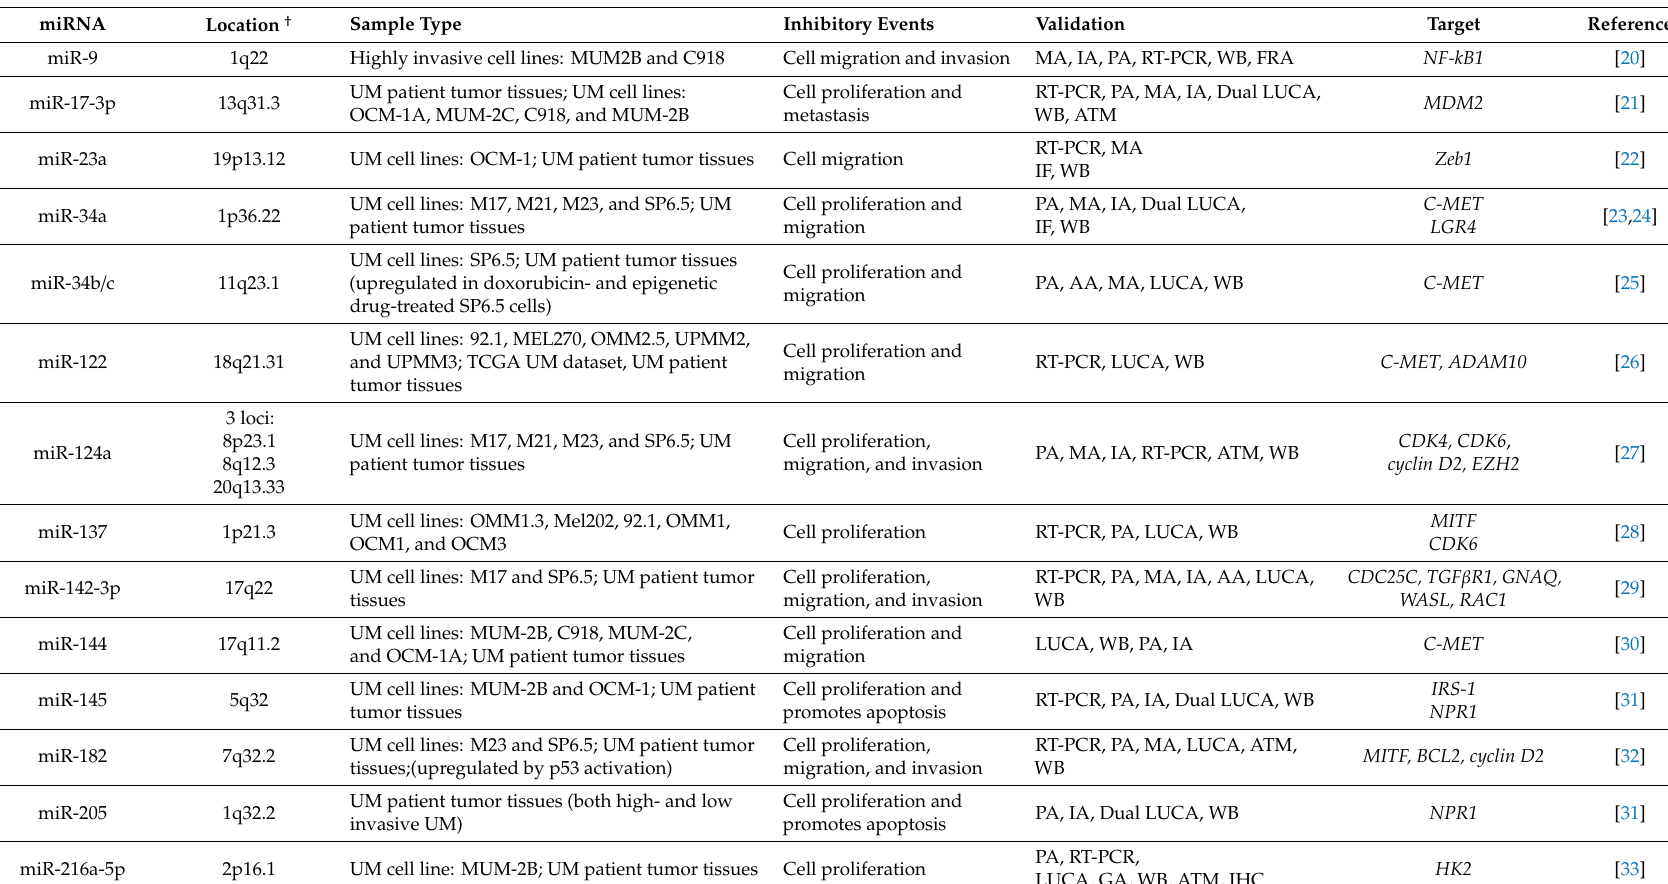
Table 1. miRNAs with UM tumor suppressor action. A list of known miRNAs with tumor suppression role in UM is shown indicating their chromosomal location, cell / tissue where it was described, their inhibitory action, gene target, existence of experimental validation, and reference. A summary indicating the main characteristics of the UM cell lines mentioned in this table are shown in Table S1